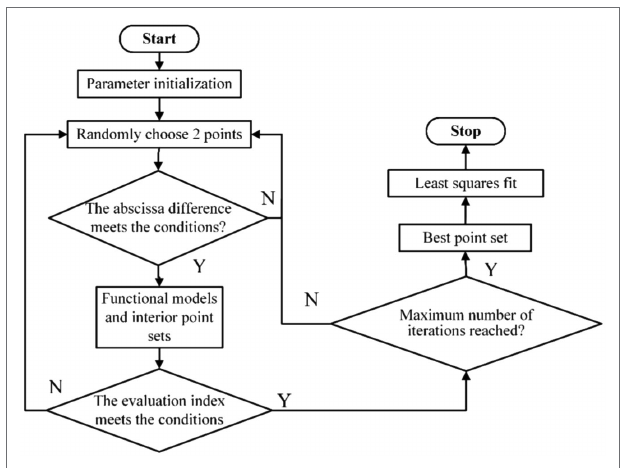
FIGURE 4 | Improved RANSAC algorithm flow